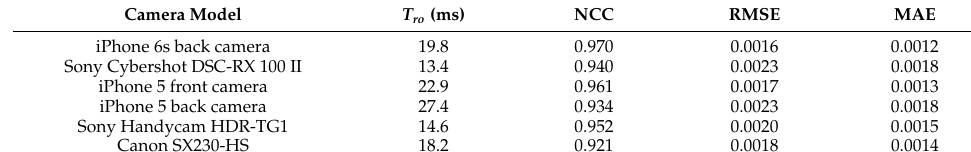
Table 2. (Dis)similarity between the extracted ENF and the reference ENF.